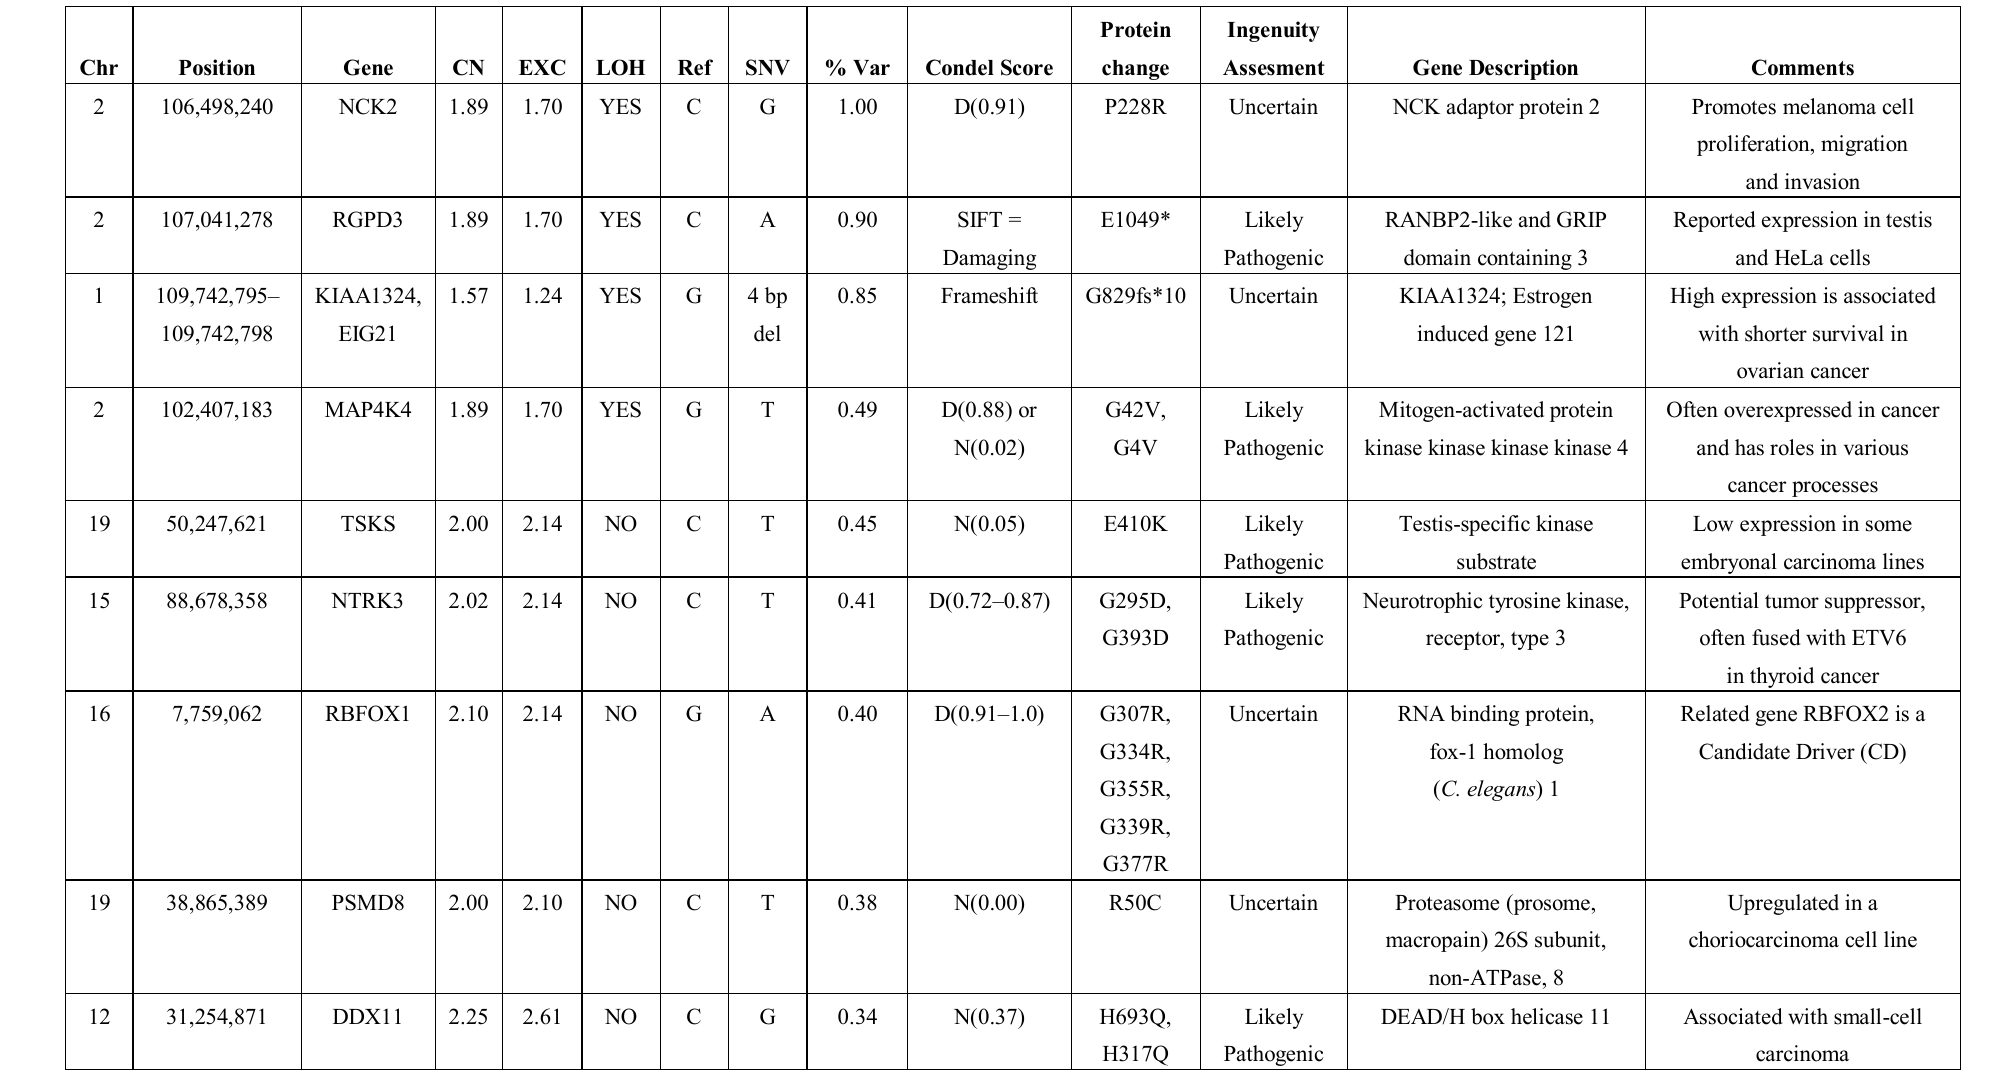
Table 2. Potentially implicated genes. Selection criteria included whether the gene function is cancer-related, a member of a gene family with established cancer drivers, or assessed as damaged by Condel or the Ingenuity Variant